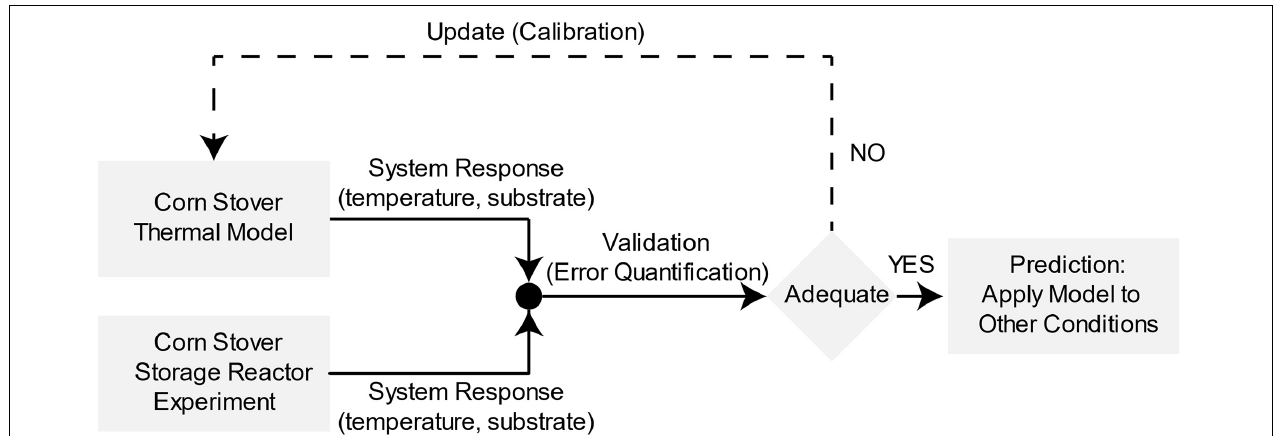
FIGURE 1 | Validation, calibration, and prediction of corn stover storage reactor dynamic thermal system. Adapted from Oberkampf and Barone (2006).